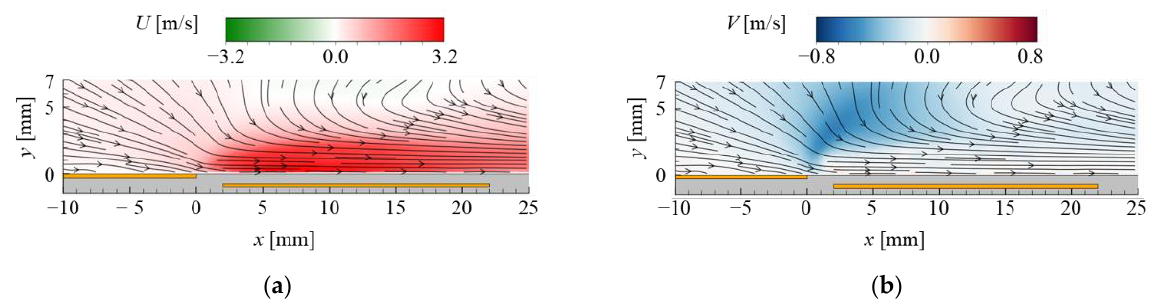
Figure 7. Photograph of the discharge emission of the plate-PA. An enlarged view of the area around the discharge is shown in a red frame: ( a ) row image; ( b ) binarized image. Figure 8. Flow velocity field of the plate-PA, obtained by PIV: ( a ) streamlines and the horizontal velocity; ( b ) streamlines and the vertical velocity.